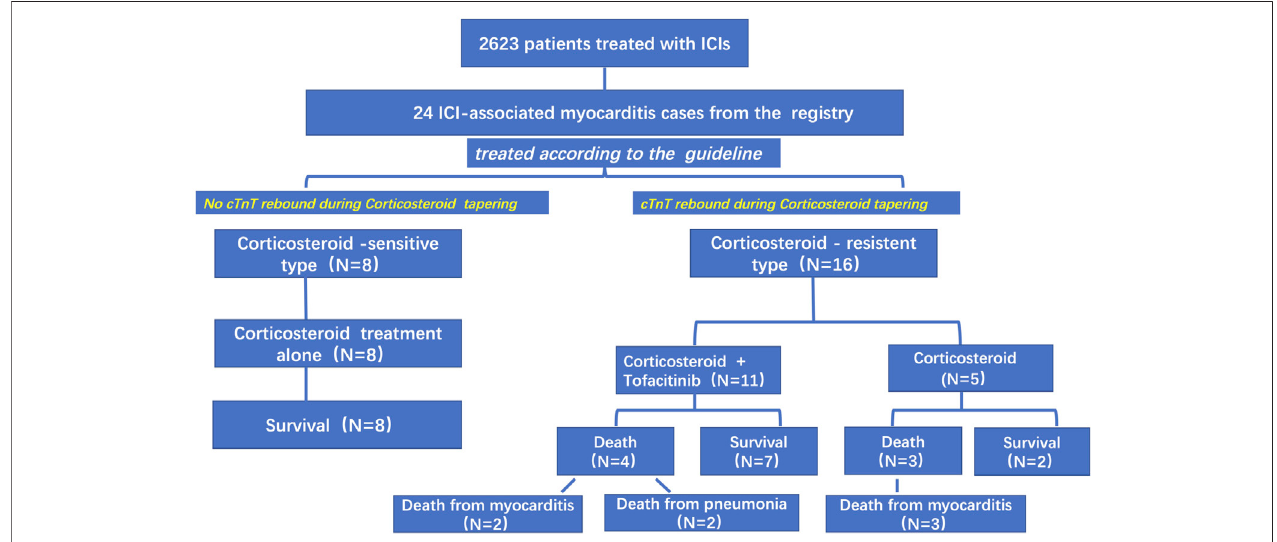
FIGURE 1 | Treatment for ICI-associated myocarditis. Based on the response to corticosteroids (troponin cTnT levels rebounding or not during corticosteroid tapering), we divided patients with ICI-associated myocarditis into corticosteroid-sensitive and corticosteroid-resistant groups.